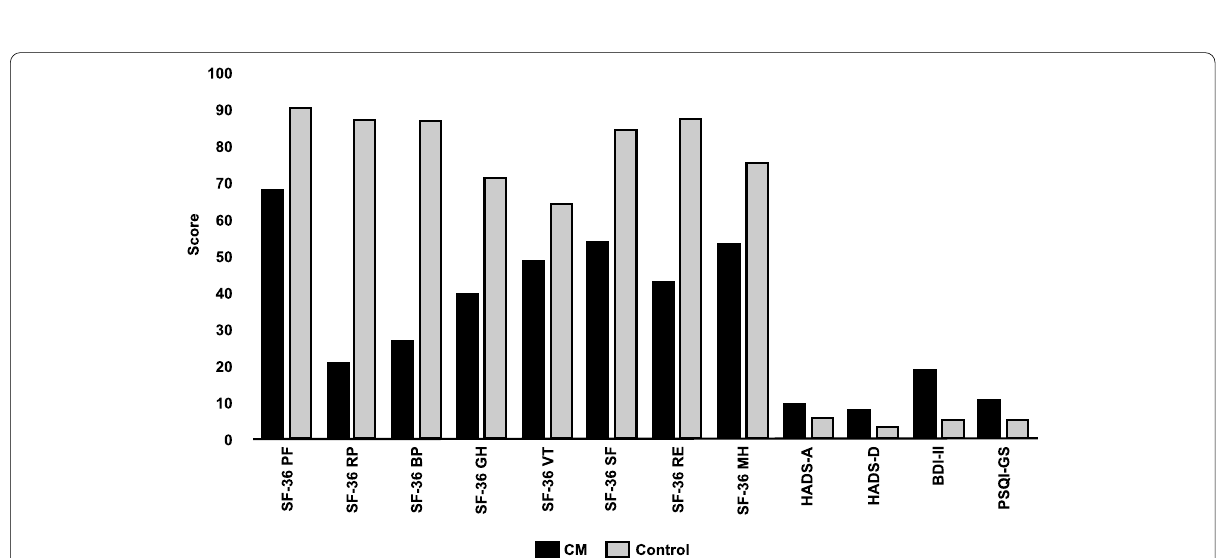
Fig. 2 Results of the QoL assessment in the CM group and the control group. Results were evaluated for the SF‑36, HADS, PSQI, and BDI scales. QoL: quality of life; CM: chronic migraine; SF‑36 PF: 36‑item Short Form Health Survey, physical functioning; SF‑36 RP: role‑physical; SF‑36 BP: bodily pain; SF‑36 GH: general health; SF‑36 VT: vitality; SF‑36 SF: social functioning; SF‑36 RE: role‑emotional; SF‑36 MH: mental health; BDI‑II: Beck Depression Inventory II; PSQI‑GS: Pittsburgh Sleep Quality Index, global